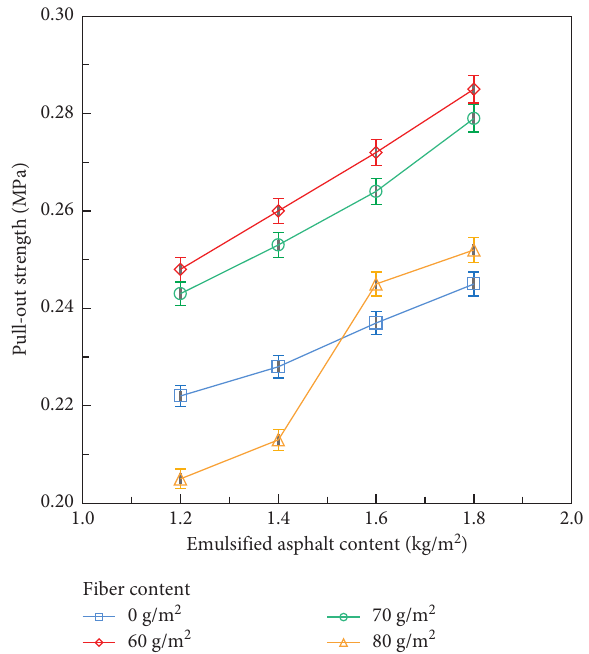
Figure 3: The results of pull-out test. Figure 4: The results of shear test.